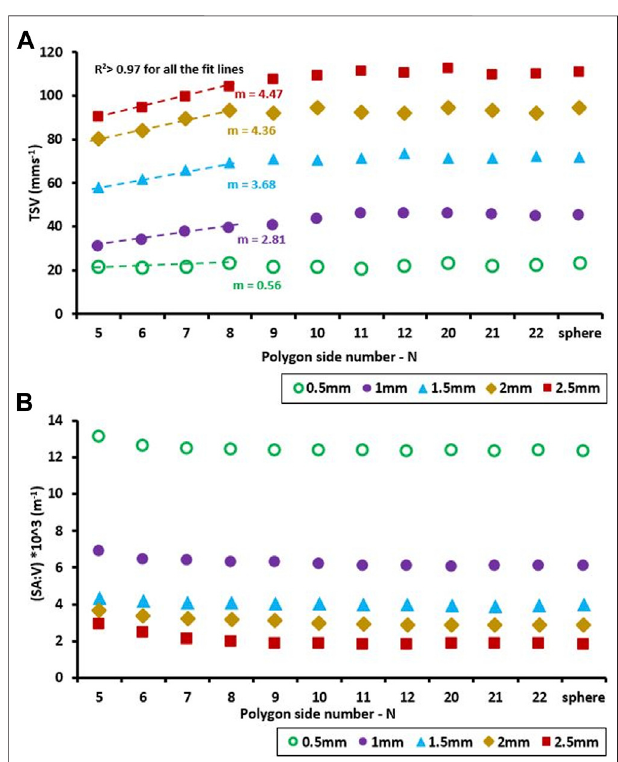
FIGURE 7 | (A) Effects of increasing roundness on TSV of MP particles for fi ve different particle sizes. The different symbols depict the different diameters of the equivalent perfect spheres, which have the same volumes as the respective virtual particles derived from the polygons. Particles in all simulations have a density of 1.38 gcm − 3 . (B) calculated SA:V for particles corresponding to the particles of panel